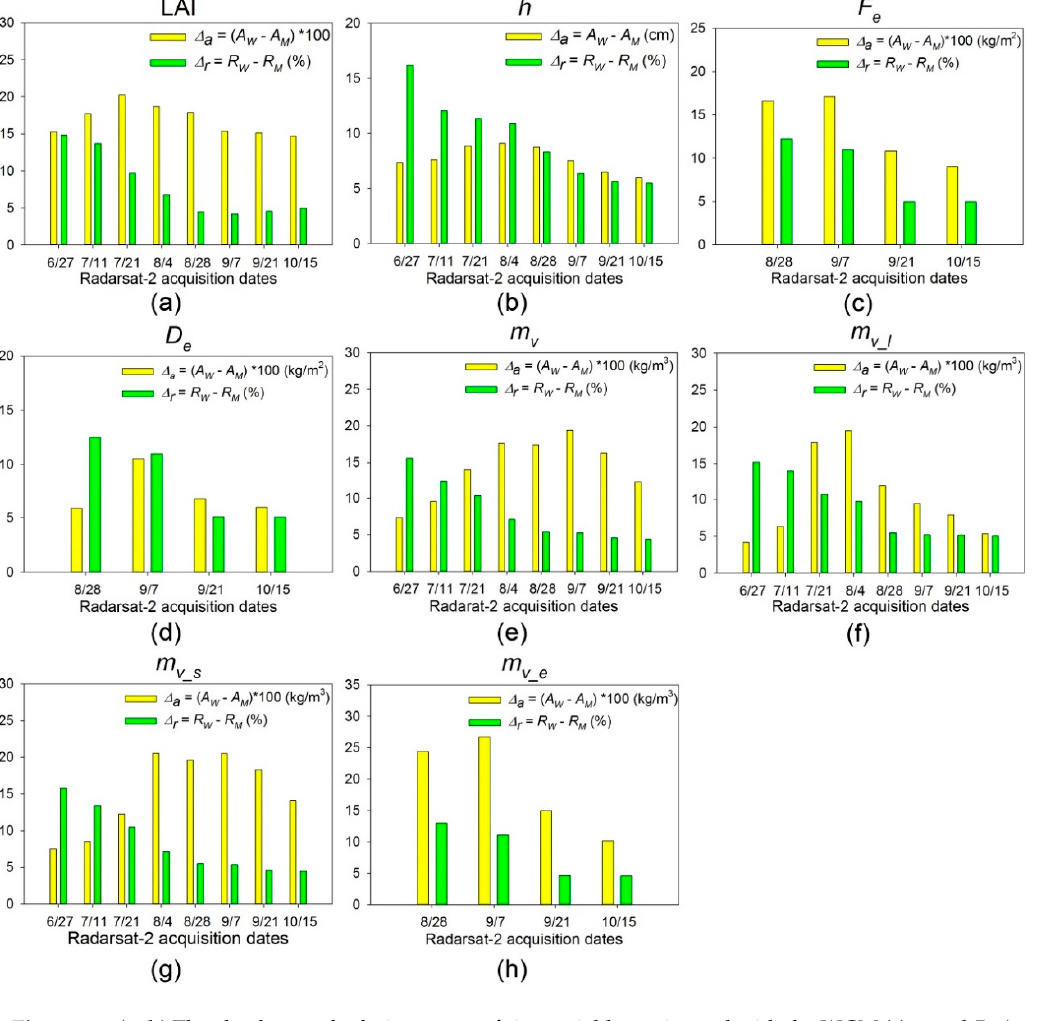
Figure 10. ( a – h ): The absolute and relative errors of rice variables estimated with the WCM ( A W and R W ) minus those estimated with the MWCM ( A M and R M